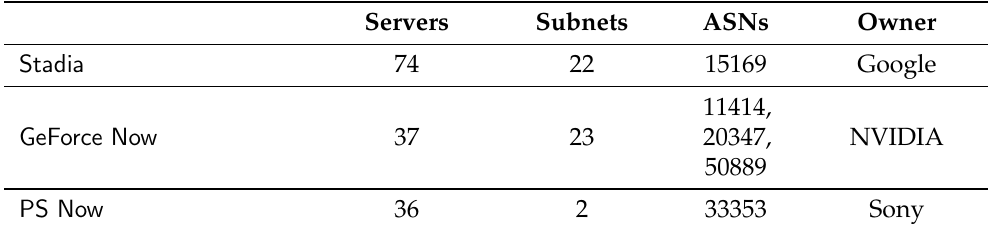
Table 3. Gaming servers